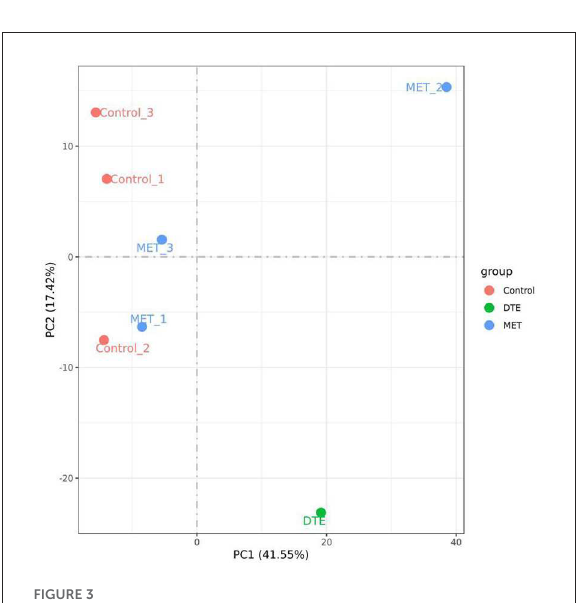
FIGURE3 The PCA of the samples. The experimental data showed significant differences between the DTE group, MET group, and control